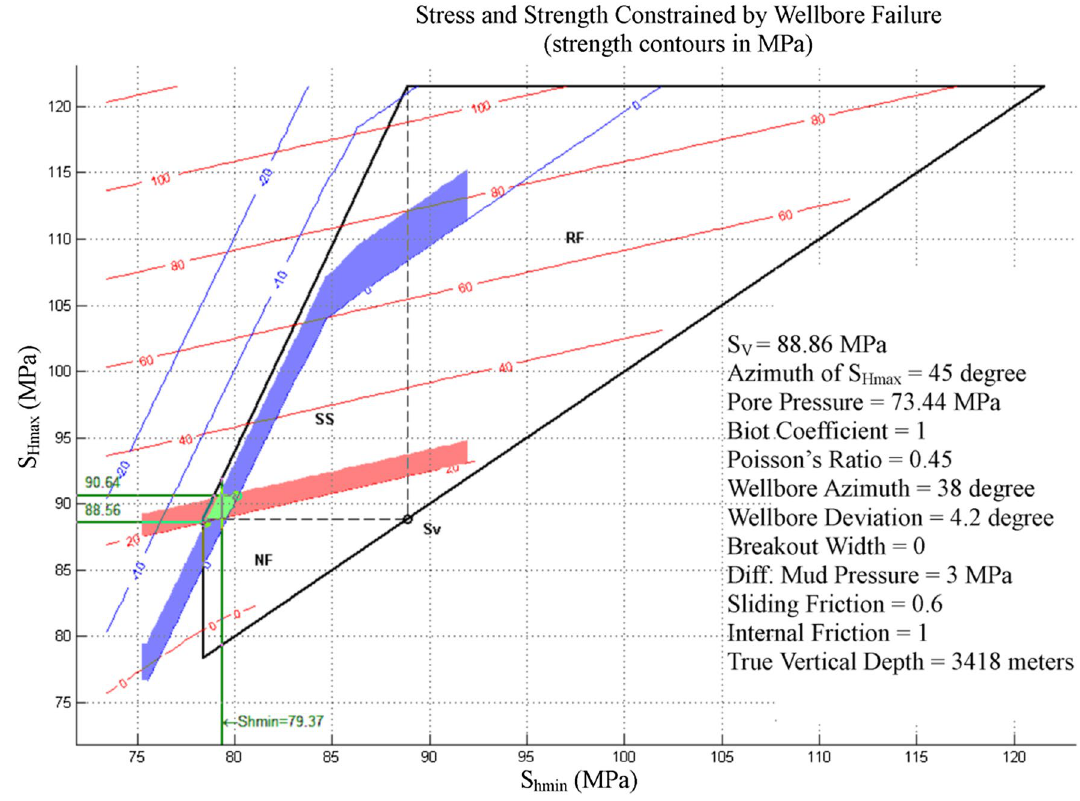
Fig. 2 Stress polygon based on the Mohr–Coulomb failure criterion for Marun 130